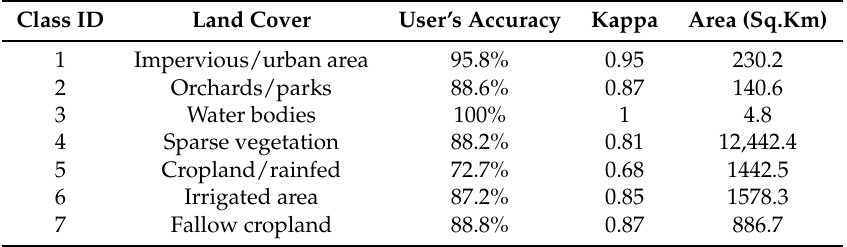
Table 4. Reported user’s accuracy, kappa estimates and surface area of major land cover classes.